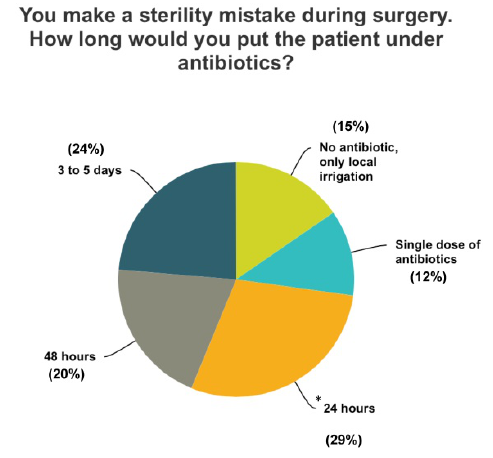
Figure 4 . Global opinion on antibiotics treatment duration.